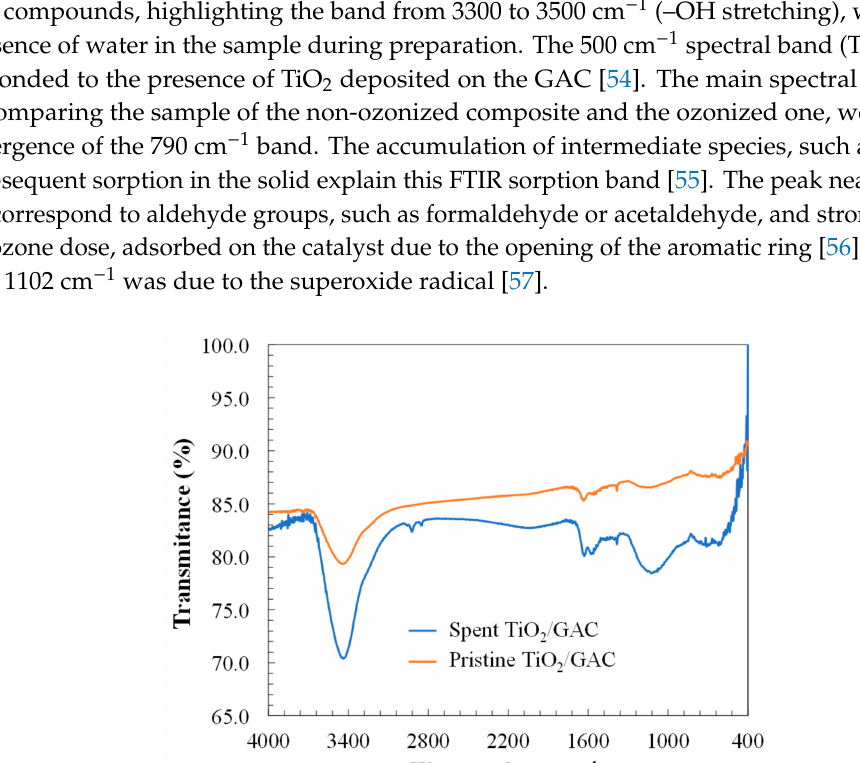
= 5.4 mg L − 1 ; pH = 7.0; M = 13.3 g L − 1 ; T = 18.0 ◦ C; CAT 3 ,in